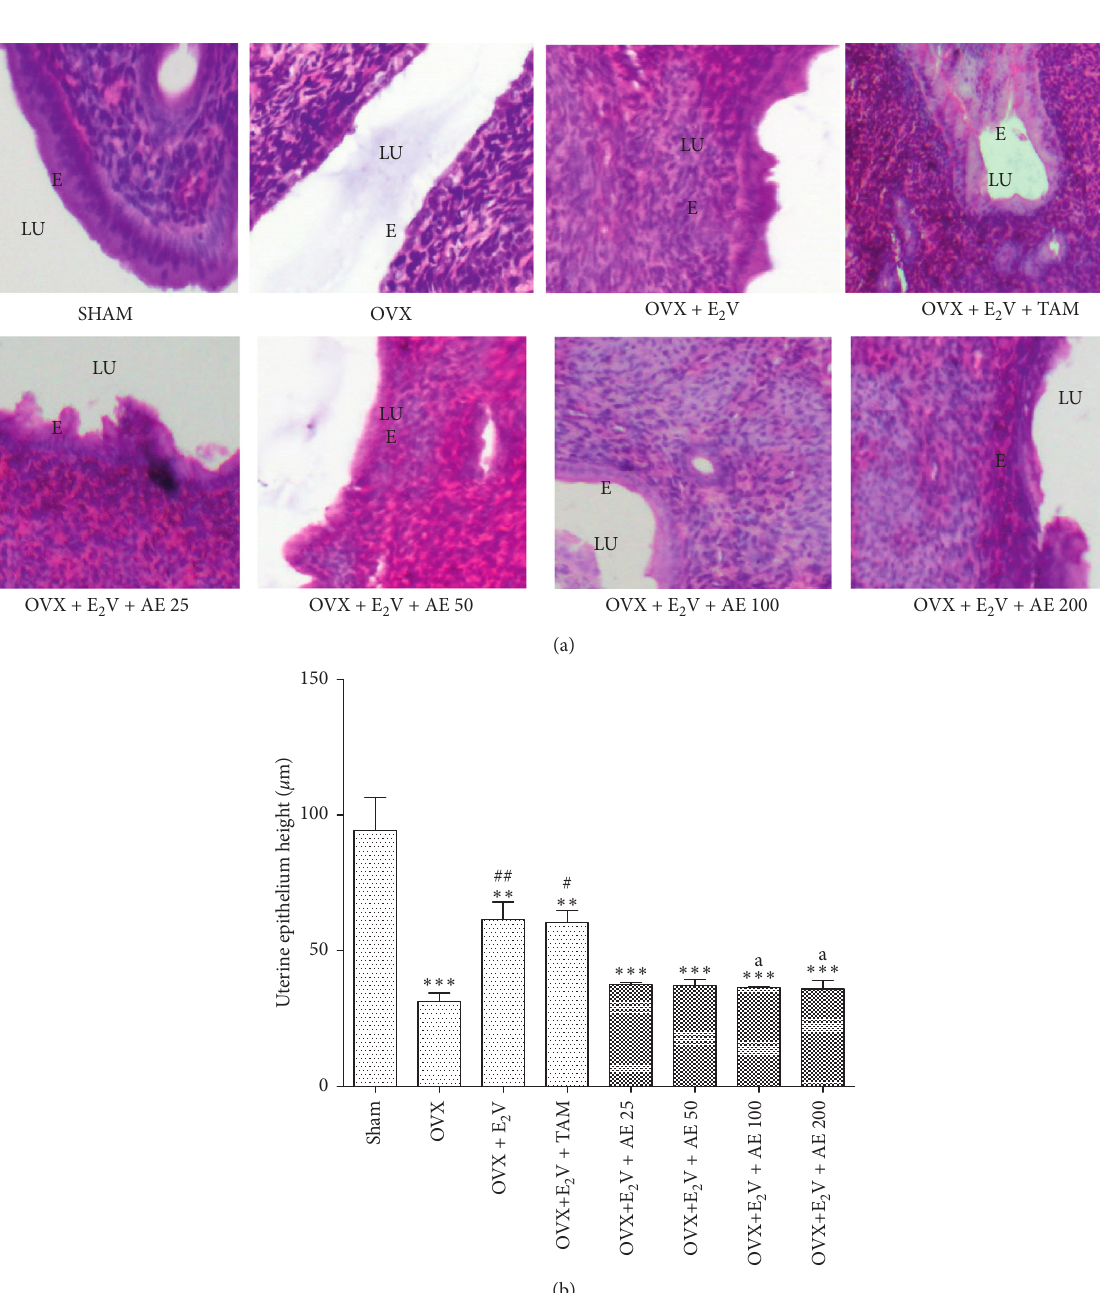
Figure 3: Microphotographs (H&E 400x) (a) and epithelial height (b) of the uterus after 3 days of treatment. SHAM: sham-operated animals; OVX: ovariectomized animals; E 2 V: estradiol valerate; TAM: tamoxifen; AE: aqueous extract of D. edulis leaves. Data are presented as mean ± S.E.M. ( n � 6). ∗∗ p < 0 . 01 and ∗∗∗ p < 0 . 001 compared with SHAM; # p < 0 . 05 and ## p < 0 . 01 compared with OVX; and a p < 0 . 05 compared with OVX +E 2 V. LU: lumen; E